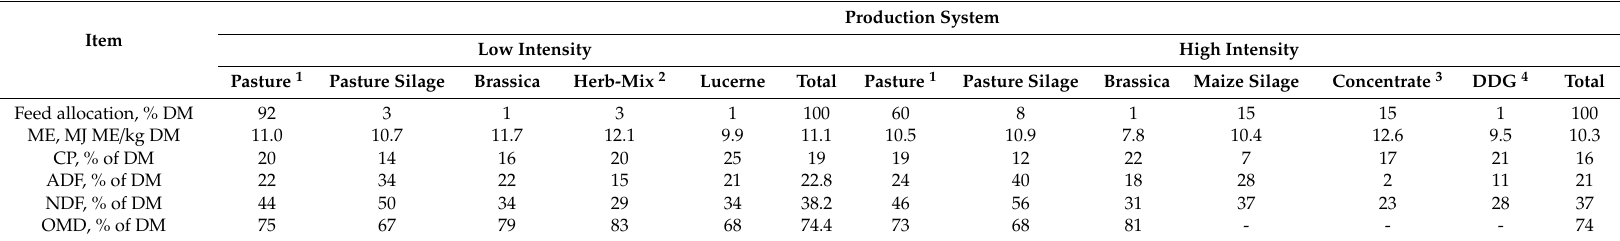
Table 1. Mean feed allocation and chemical composition o ff ered before each herd test in two contrasting pasture-based dairy production systems. Chemical composition expressed in metabolisable energy (ME, MJ ME / kg DM), and in percentages of crude protein (CP), acid detergent fibre (ADF), neutral detergent fibre (NDF), and organic matter digestibility